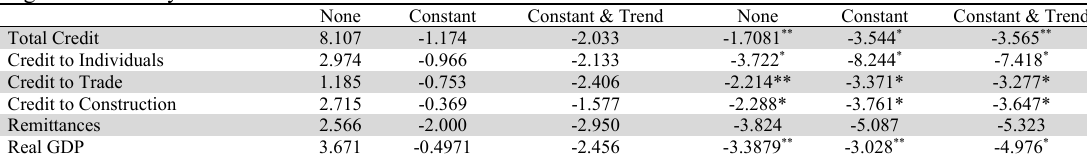
Fig. 3. The Inflow of Remittances to GDP Ratio in Jordan E. All six variables become stationary once first-differenced (Table 2). Augmented Dickey-Fuller Unit Root Test